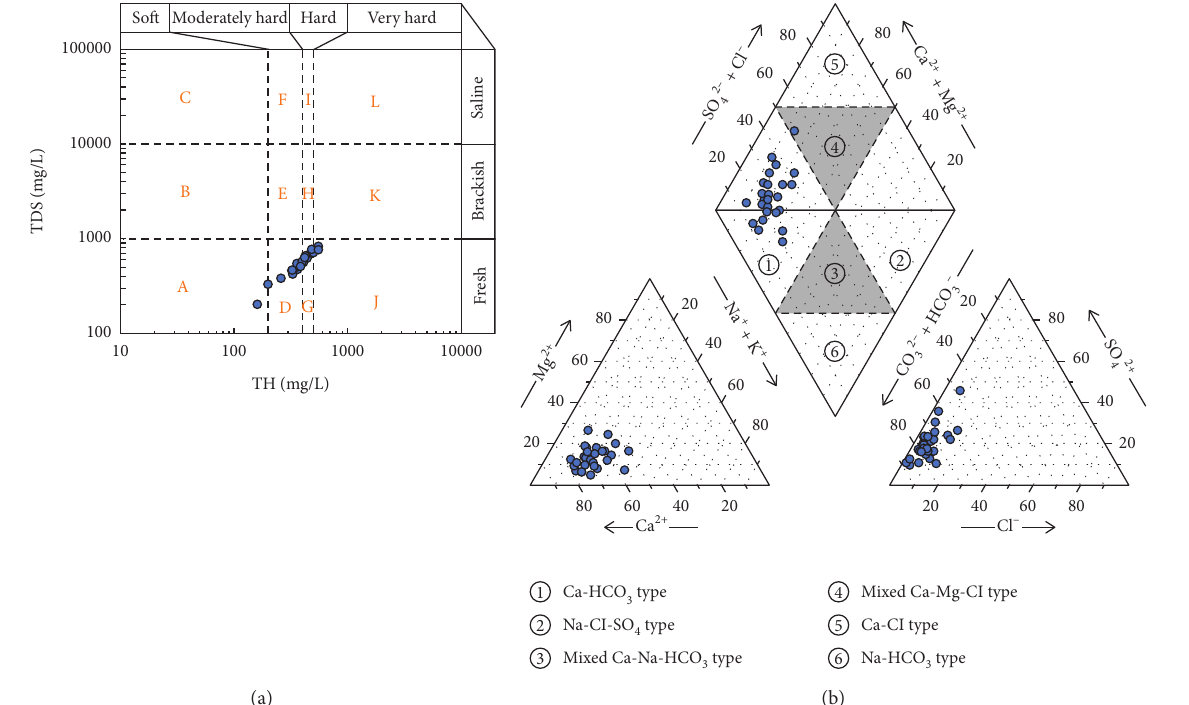
Figure 4: Scatter plots of (a) TH versus TDS demonstrating groundwater quality and (b) Piper trilinear diagram for groundwater samples.